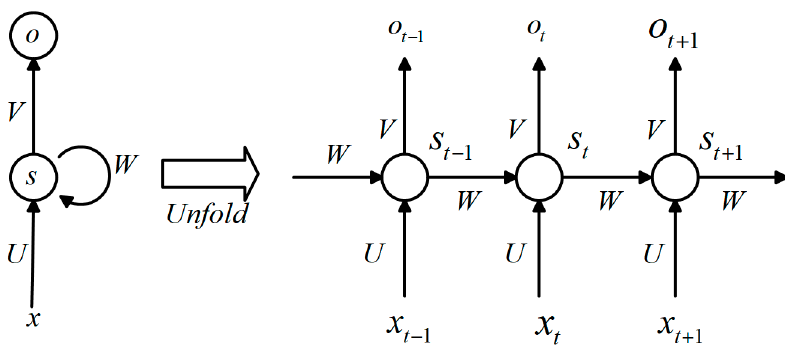
Figure 1. Basic recurrent neural networks structure.